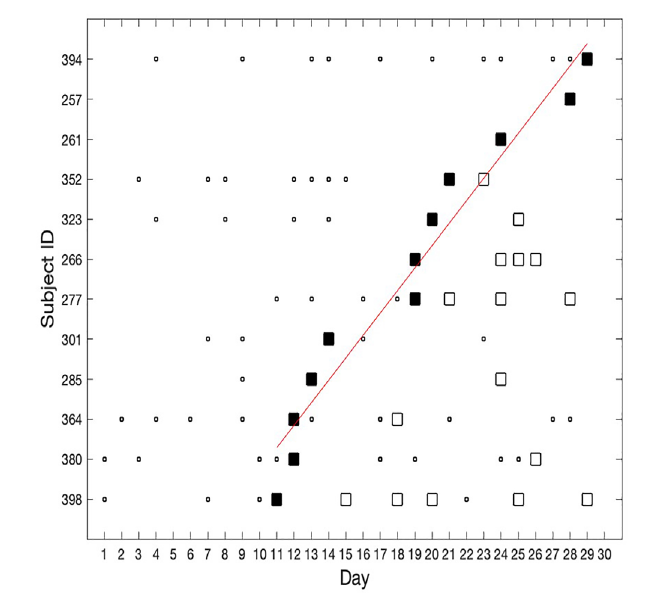
Figure 2. Subjects with IgG positivity (via Antibody Fast Detection Kit (Colloidal Gold) Superbio, Timisoara, Romania), ordered by the first day on which each subject became positive. Vertical axis: subject identification number ordered from earliest day of IgG seropositivity (bottom) to latest day (top). Horizontal axis: day of the study. Small squares: negative IgG test. Large solid squares: first positive IgG test. Hollow squares: subsequent positive IgG test. Red line: linear regression of initial IgG positivity by day of study with a slope of 0.56 cases per day.